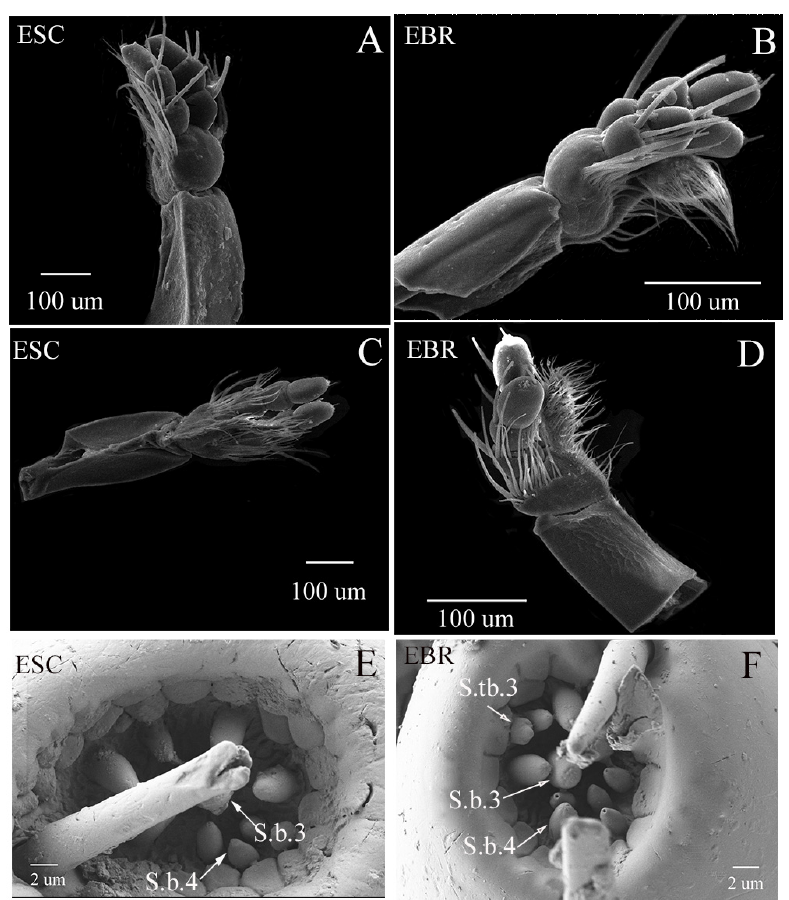
whole rostrum tube cuticle in E. scrobiculatus was significantly larger than that of E. brandti Figure 4. Scanning electron micrographs showing the labium of Eucryptorrhynchus scrobiculatus (ESC) females and E. brandti (EBR) females. ( A ) © ventral of E. scrobiculatus labium; ( B ) the ventral of E. brandti labium; ( C ) the dorsal of E. scrobiculatus labium; ( D ) the dorsal of E. brandti labium. ( E ) the apex of labial palpus of E. scrobiculatus ; ( F ) the apex of labial palpus of E. brandti. S.b.3-4, sensilla basiconica; S.tb.3, sensilla twig basiconica.